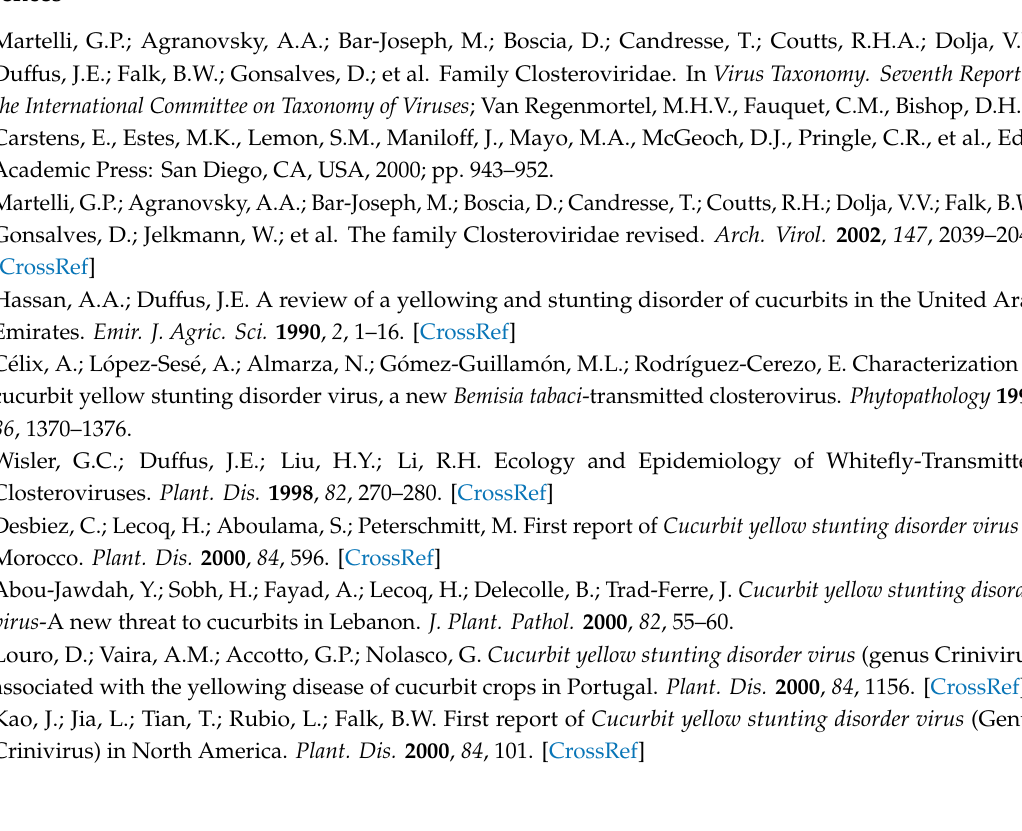
s1. Figure S1. Generations used and experiments carried out. Table S1. Symptom evaluation and qRT-PCR result after inoculation with CYSDV of the RIL population and advanced derived backcrosses. Table S2. Correlations between parameters used for disease assessment (symptom scores and qRT-PCR Ct values) in the RILs population in the di ff erent assays. Table S3. Genotype of RILs 110, 278 and 556 for the markers in GBS 1. Table S4. Marker sets (CYSDV1 and CYSDV2) used in genotyping of progenies. Table S5. Gene loci in the region of the candidate interval for the major QTL for resistance to CYSDV derived from